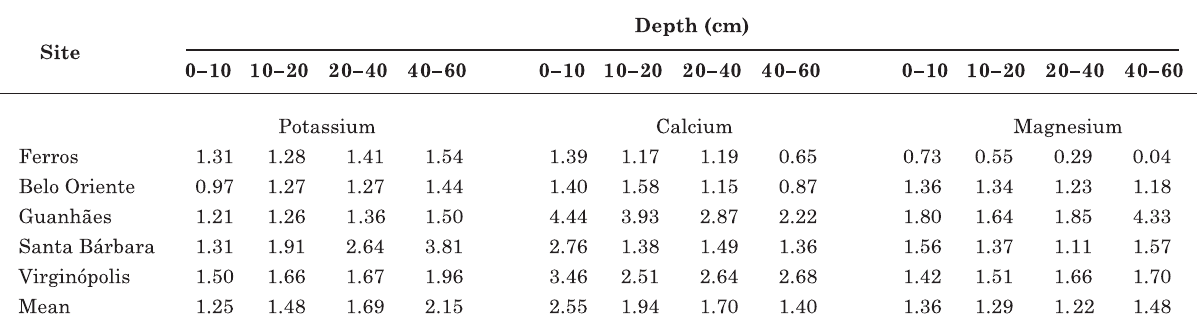
Table 7. Non-exchangeable to exchangeable K, Ca, and Mg ratios in soil samples taken from eucalyptus stands at different depths in the five studied